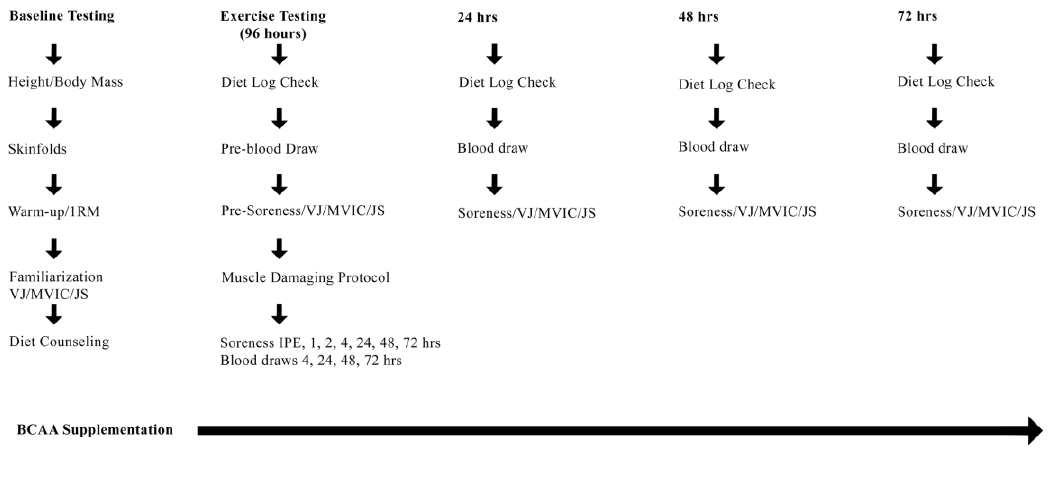
Figure 1. Experimental design overview. Participants were supplemented for 8 days with either BCAA or placebo following baseline assessment. Participants returned to the lab 96 hr following baseline assessment.